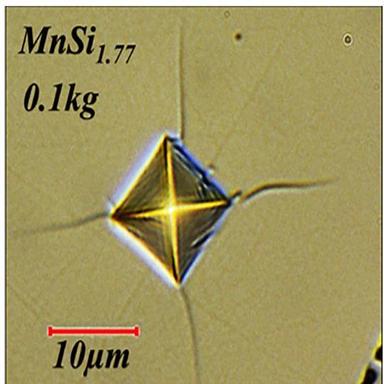
Vickers microhardness indentations of a) MnSi1.77 and b) Mg2Si0.6Sn0.4.